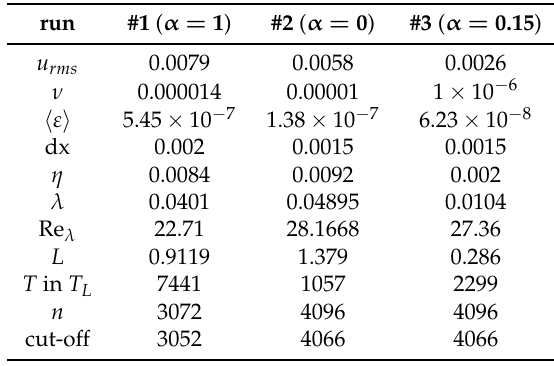
Table 1. Characteristic parameters of the numerical simulations: root mean square velocity u rms = (cid:112) (cid:104) u 2 (cid:105) , viscosity ν , averaged rate of local energy dissipation (cid:104) ε (cid:105) = 2 ν dissipation length η = integral length scale L = u cut-off of the power law forcing. The intermediate case ( α = 0.15) included a damping term of the form − γ u ( x , t ) with γ = 0.002 on the r.h.s. of Equation (26).